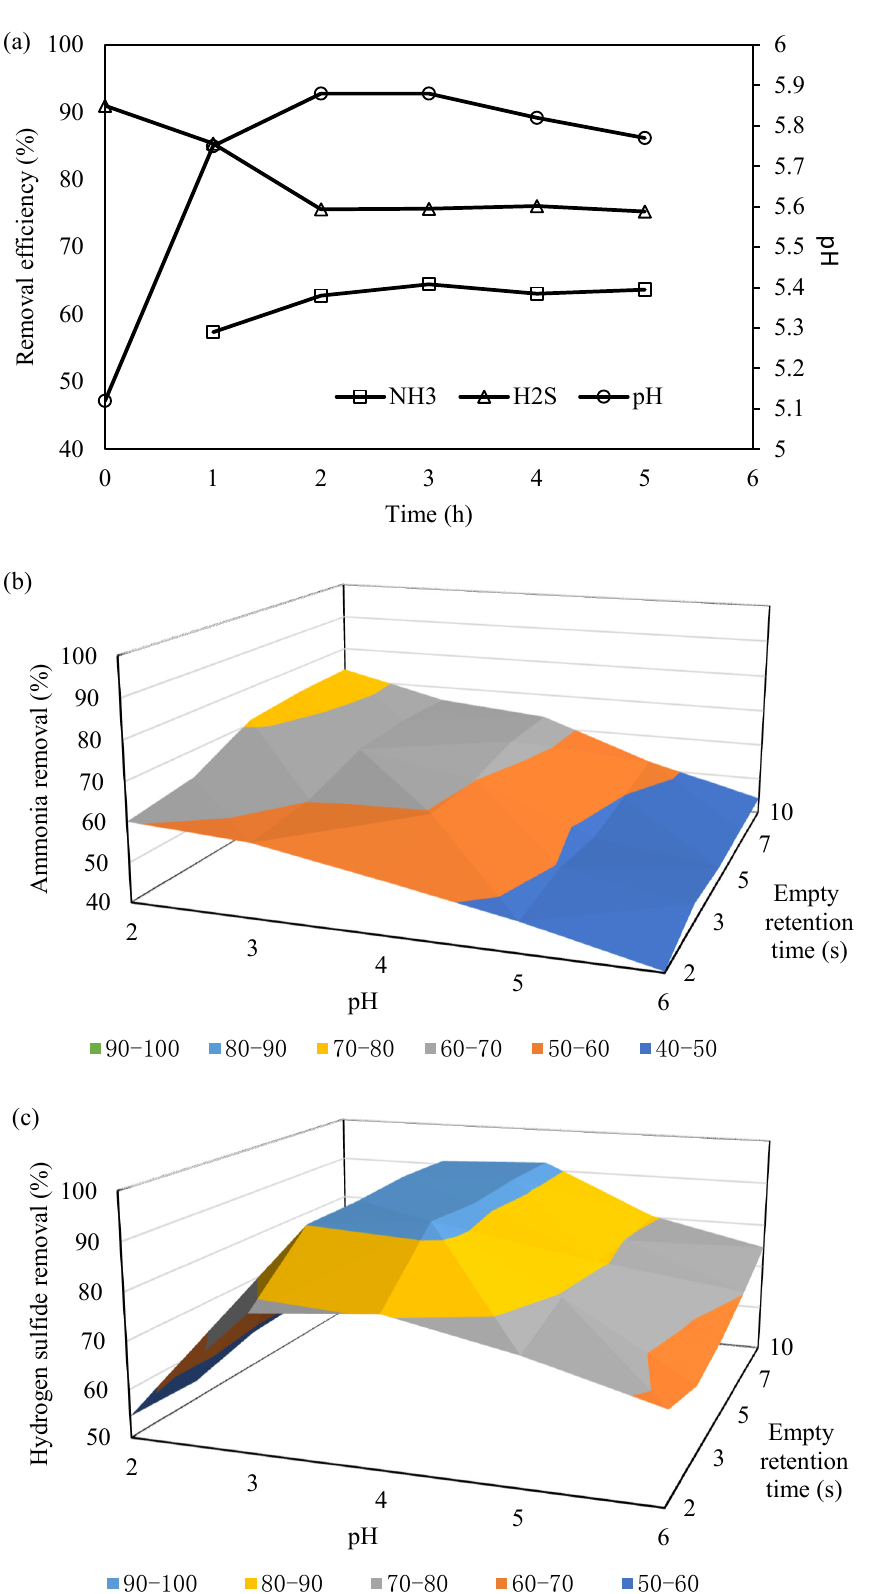
Figure 3. The ammonia and hydrogen sulfide removal by biotrickling filter: ( a ) ammonia and hydrogen sulfide removal with empty bed retention time of 10 s; ( b ) the ammonia removal at different pH and empty bed retention time; ( c ) hydrogen sulfide removal at different pH and empty bed retention